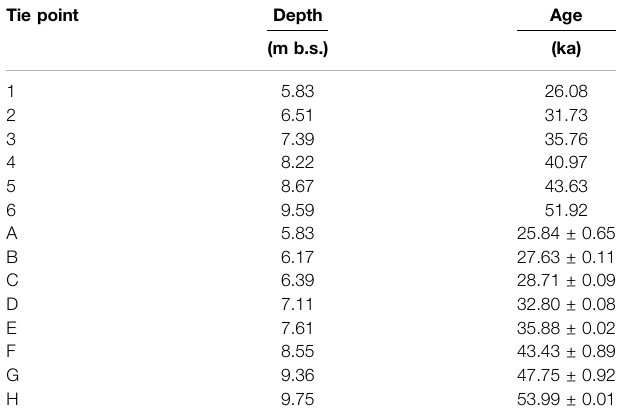
TABLE 3 | Tie points of RPI correlation (1 – 6, cf. Figure 6 ) assigned to the ages resulting from correlation with GLOPIS-GICC05. Tie points resulting from correlation of magnetic susceptibility data (A-H, cf. Figure 6 ) are shown as mean ages and their age variation. These values do not represent con fi dence